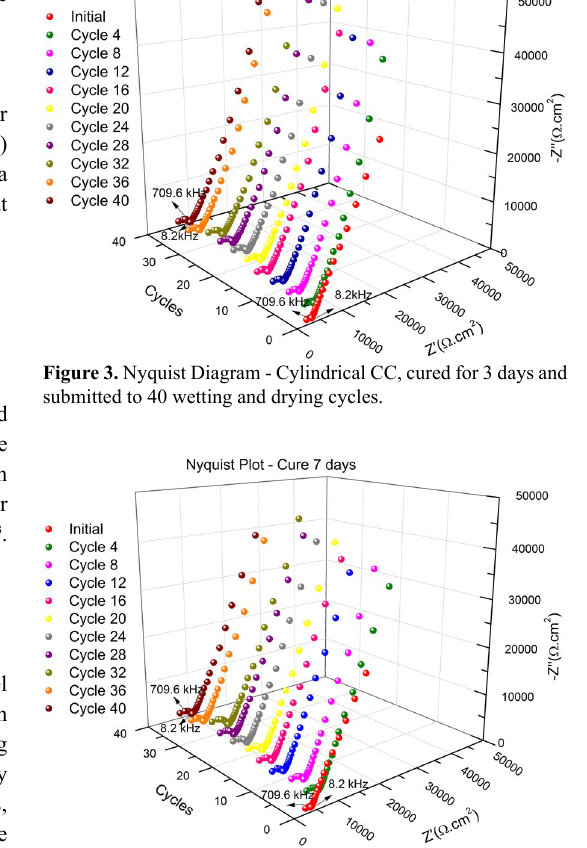
Figure 4. Nyquist Diagram - Cylindrical CC, cured for 7 days and submitted to 40 wetting and drying cycles.